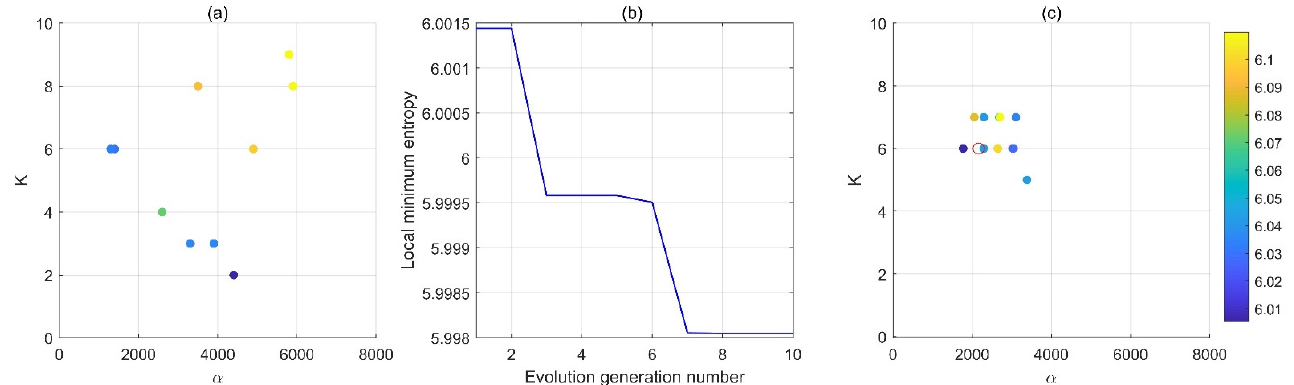
Figure 6. Determination of the optimal combination of [ K , α ] by PSO for the average trace in Figure 5. ( a ) Initial position of the ten particles, ( b ) The change of local minimum entropy value with population evolution generation, ( c ) the final position of the particles with the optimum value is marked in the red circle.